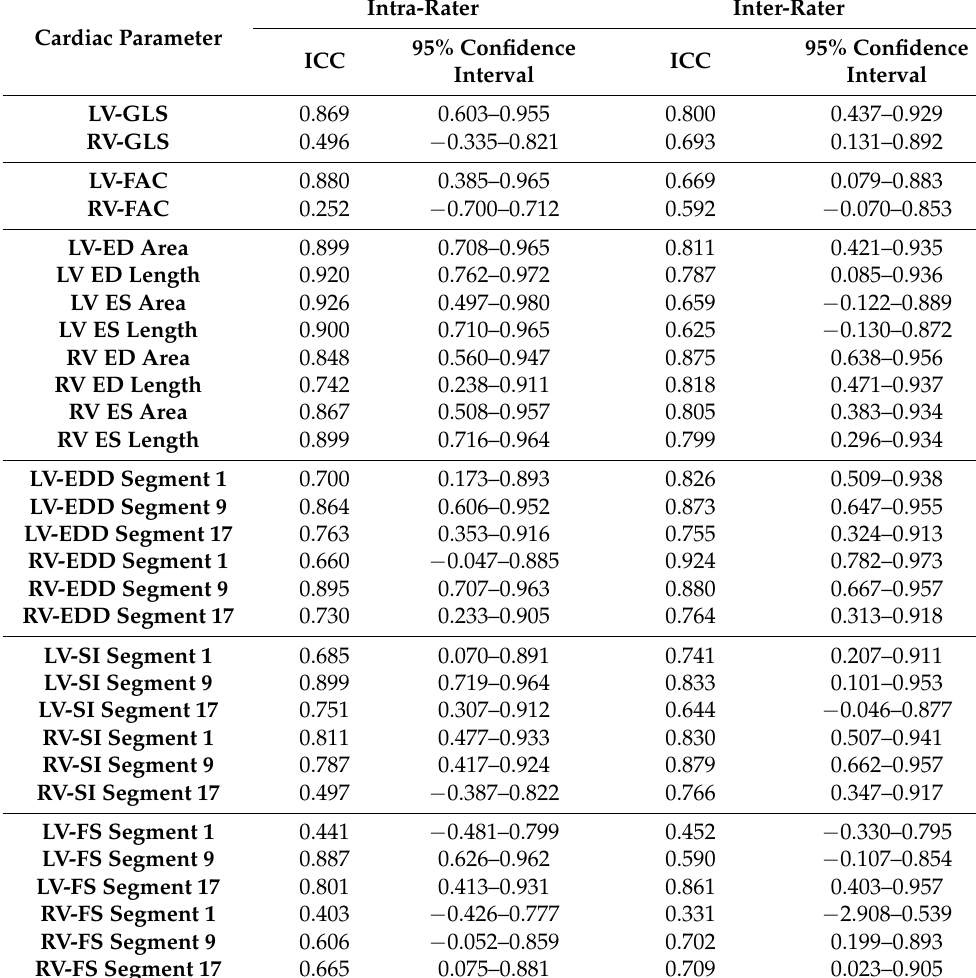
Table 3. Intra-rater and inter-rater reliability for FetalHQ ® cardiac